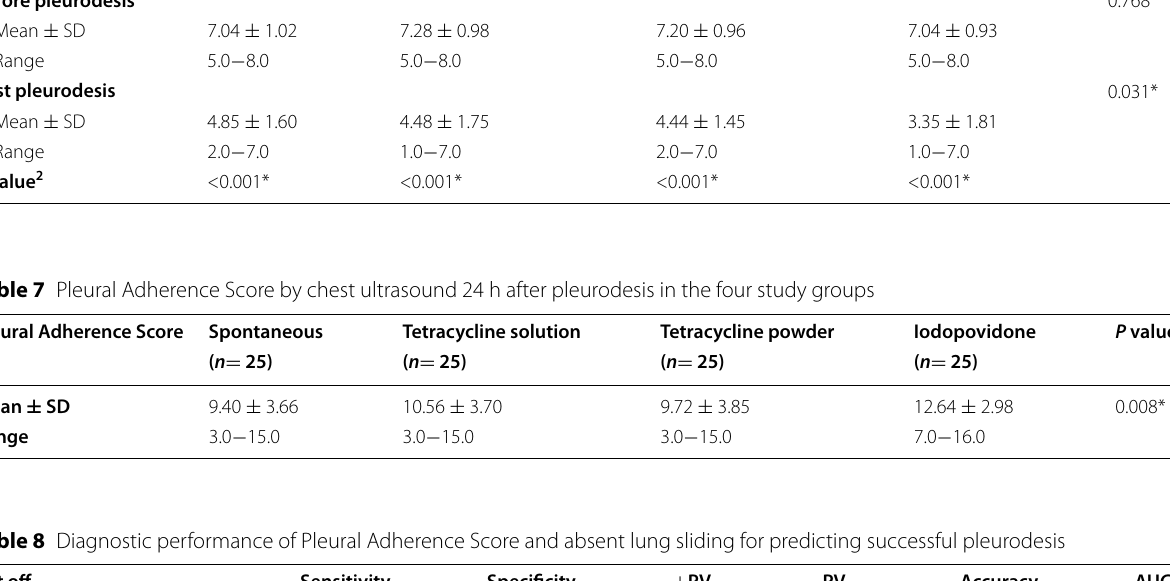
Table 6 Baseline and post-pleurodesis lung sliding score by chest ultrasound Lung sliding score Before pleurodesis